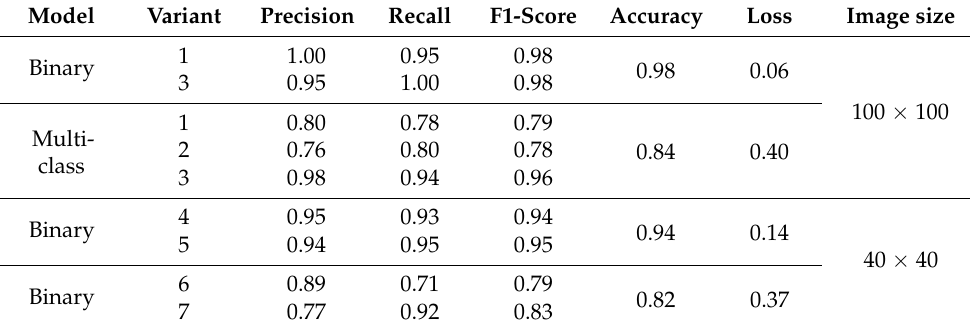
Table 4. Classification